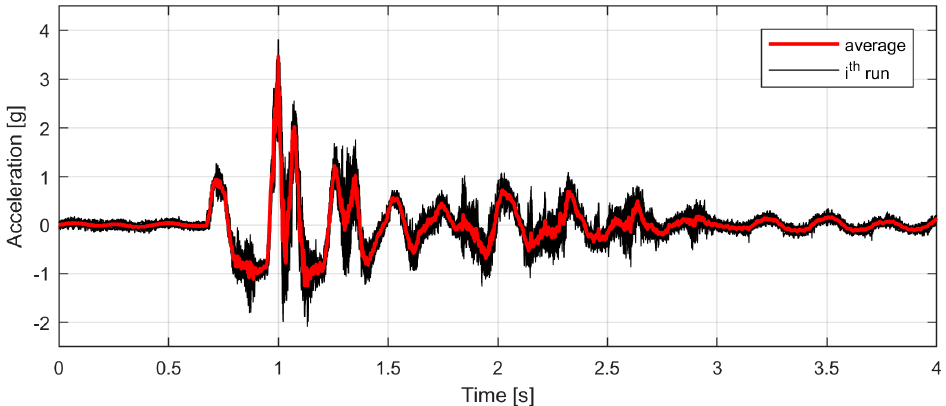
.. z FL av and the 15  FL z and the 15 acquisitions. av